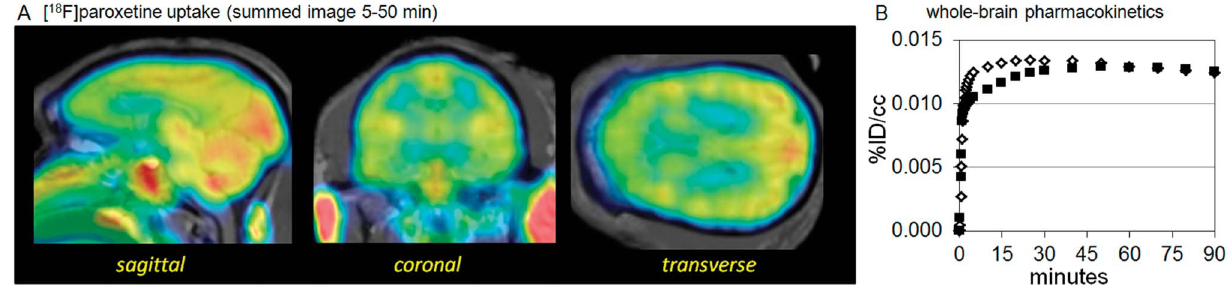
Figure 9. Distribution and pharmacokinetic profile of [ 18 F]paroxetine ([ 18 F]-1) from MR-PET imaging in non-human primates. (A) Summed images from 5–50 min of the dynamic PET collected following injection of [ 18 F]-1 . The images are fused with a structural (T1 weighted) MR image. Although [ 18 F]-1 is a potent and selective ligand for the serotonin transporter (SERT), the observed binding does not match the distribution of SERT. This is indicative of high non-specific binding. The images highlight the overall high blood-brain-barrier penetration of [ 18 F]-1 and heterogeneity of binding observed. (B) Whole-brain average time-activity curves from [ 18 F]-1 from baseline and pretreatment (citalopram) studies.